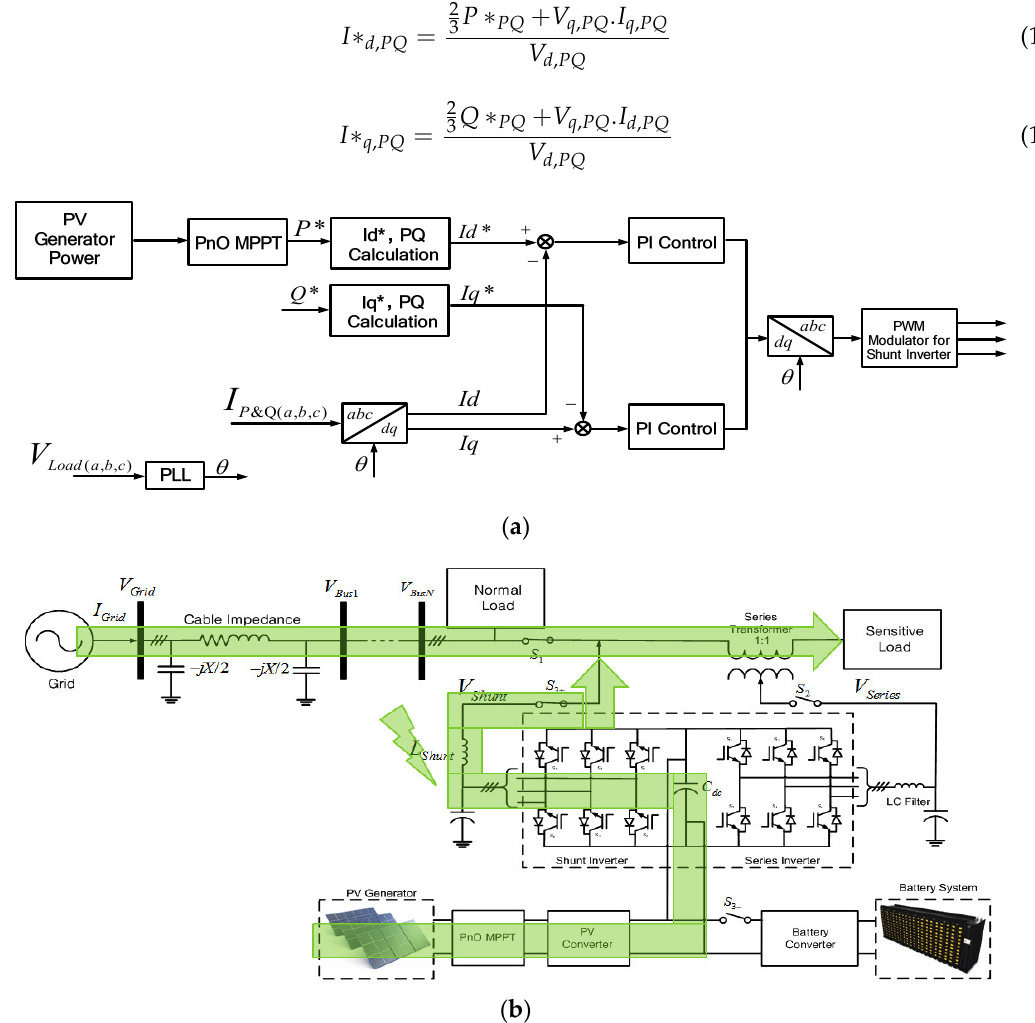
Figure 6. Normal mode: ( a ) Control scheme for shunt inverter; ( b ) power flow condition.